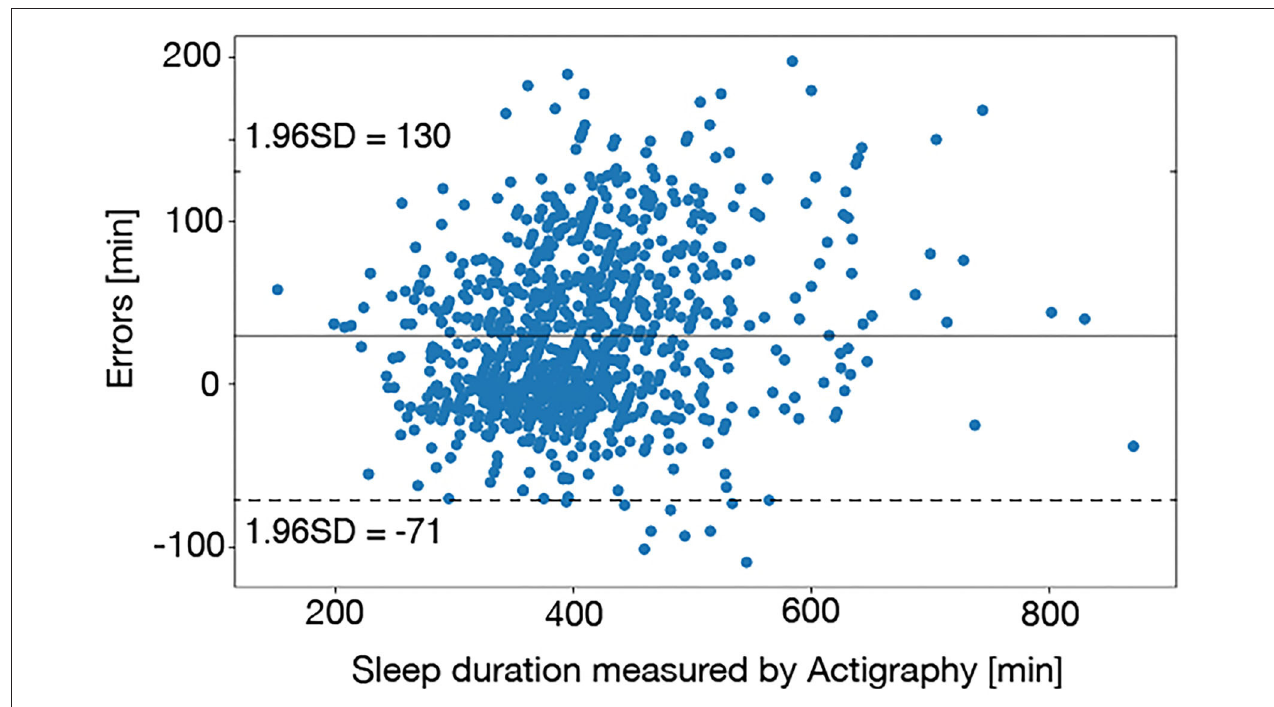
FIGURE 4 | The Bland-Altman plot between sleep durations derived from the actigraphy and the sleep diaries. Most of the sleep duration errors were scattered within 1–1.5h, which was appropriate accuracy.